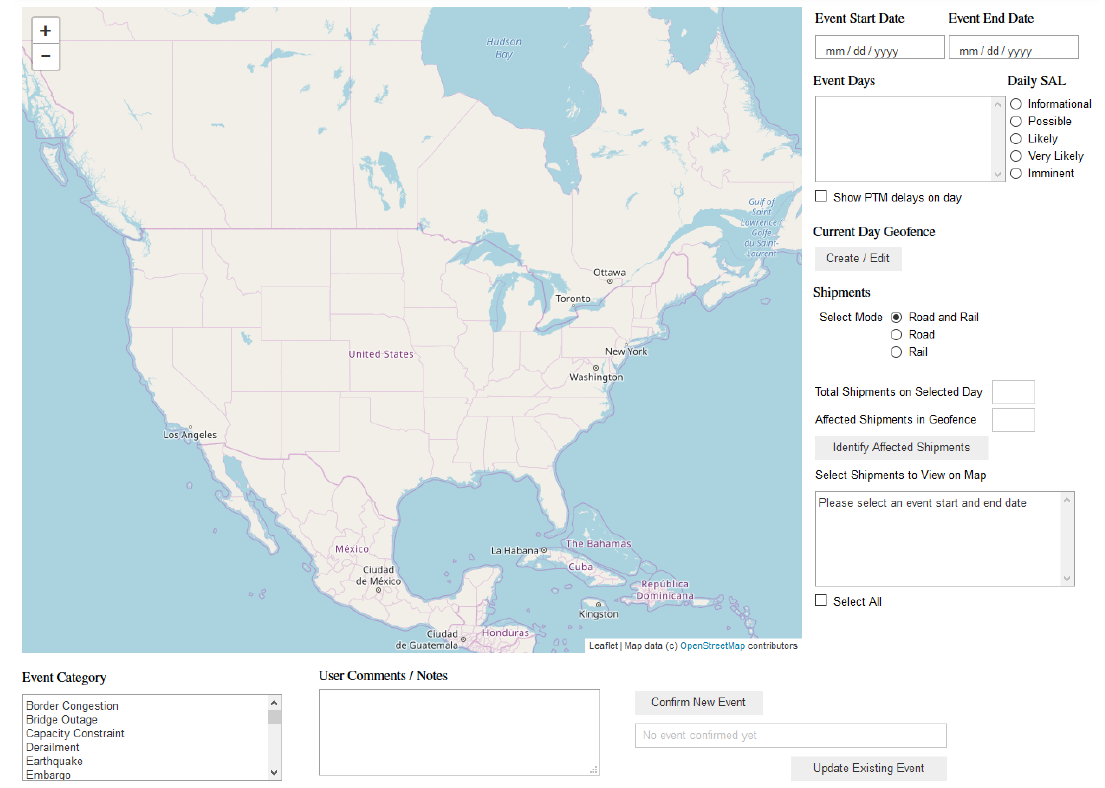
Figure 7. A graphical user interface for drawing geofences, observing affected shipments, and submitting events to the RA